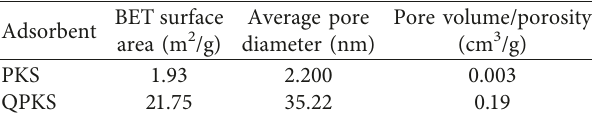
Table 3: Pore characteristics of adsorbents. BET surface Adsorbent area (m 2